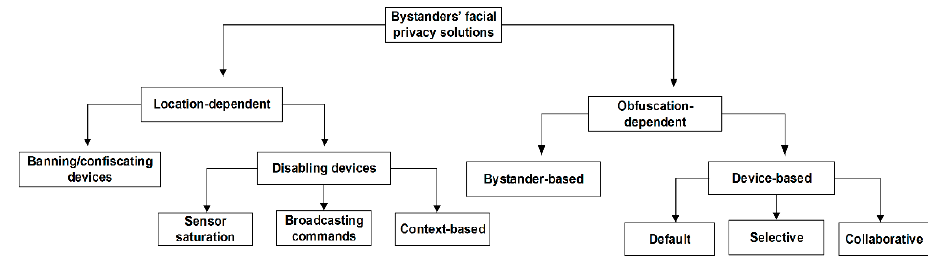
Figure 1. Taxonomy of methods for bystanders’ privacy protection [2].